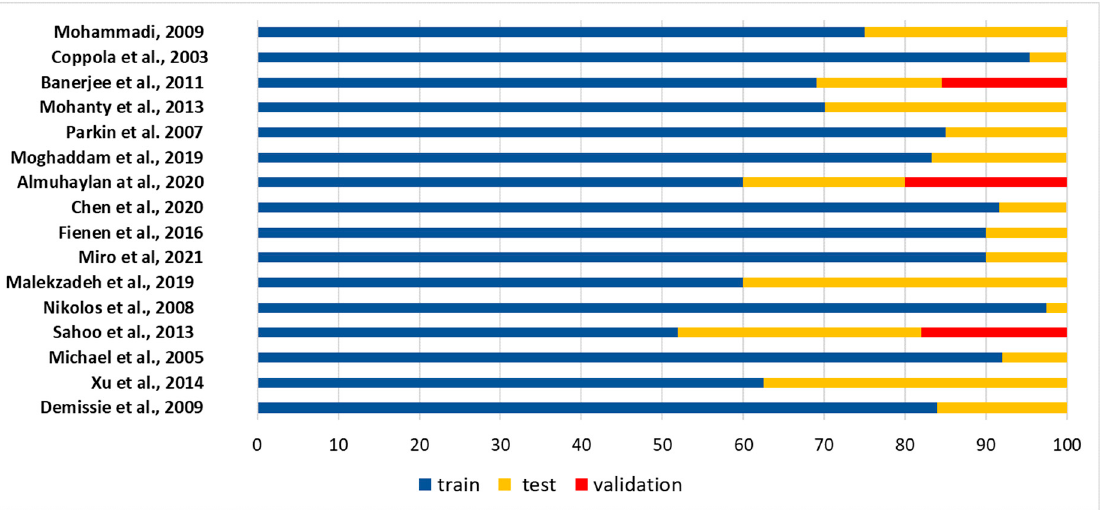
Figure 5. Percentage of the training and testing datasets used in machine learning modelling. Data from: Mohammadi, 2009 [59], Coppola et al., [3], Banerjee et al., 2011 [96], Mohanty et al., 2013